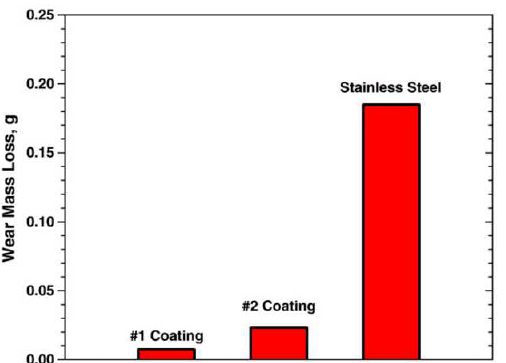
Figure 25. Wear mass loss of the laser-clad Co 3 Mo 2 Si/Co coatings in comparison with the stainless steel [124].